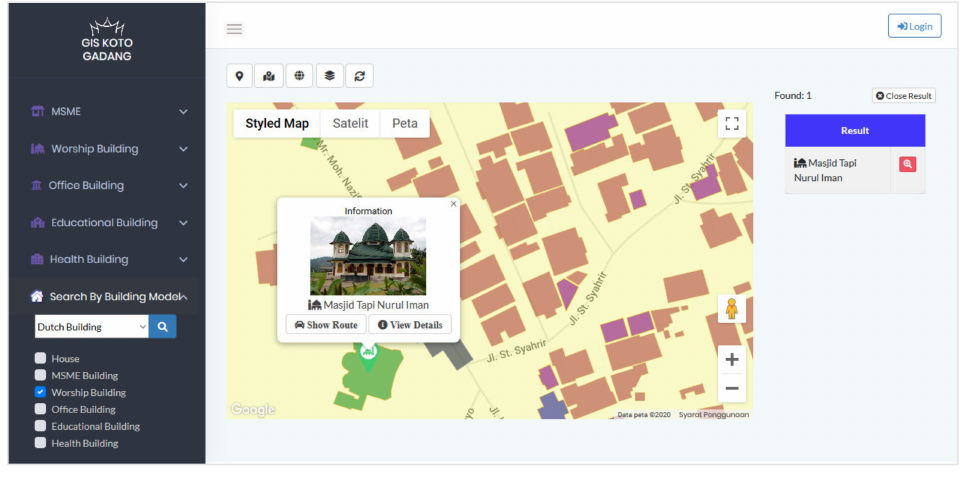
Figure 12. The mosque featuring Dutch